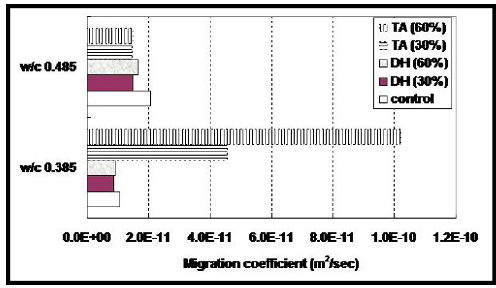
Figure 9. Porosity measurements in cement mortar without HWRA.